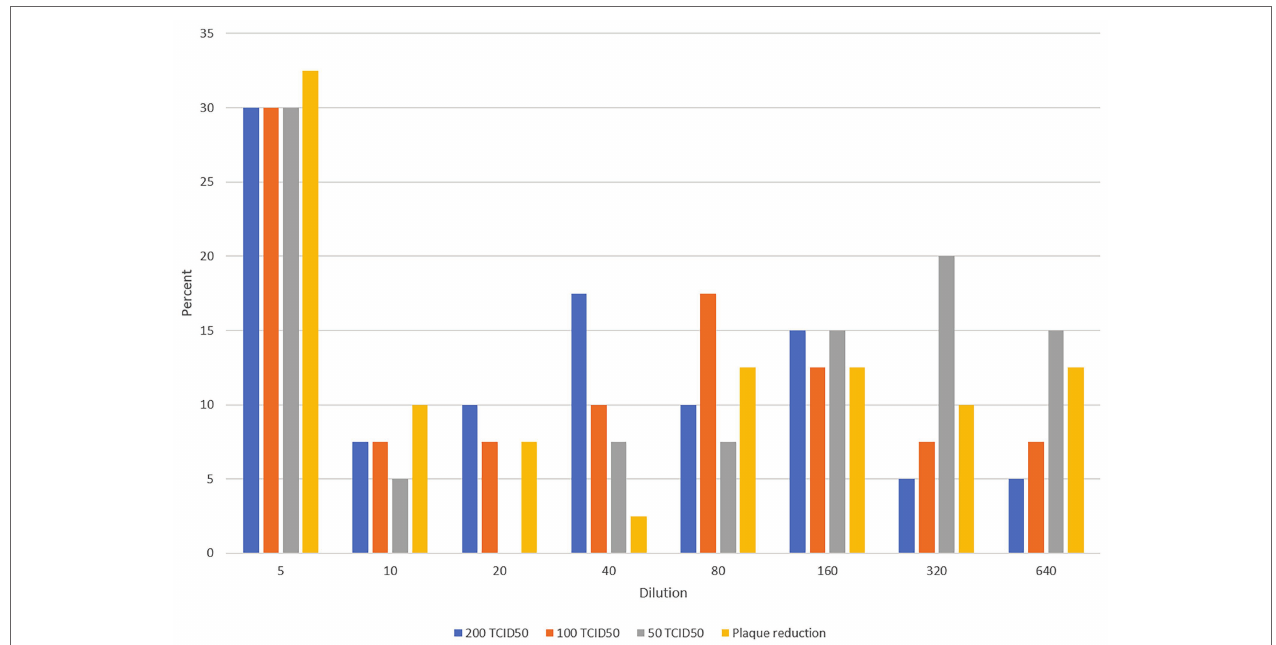
FIGURE 2 | Distribution of titers resulting from various neutralization assays.